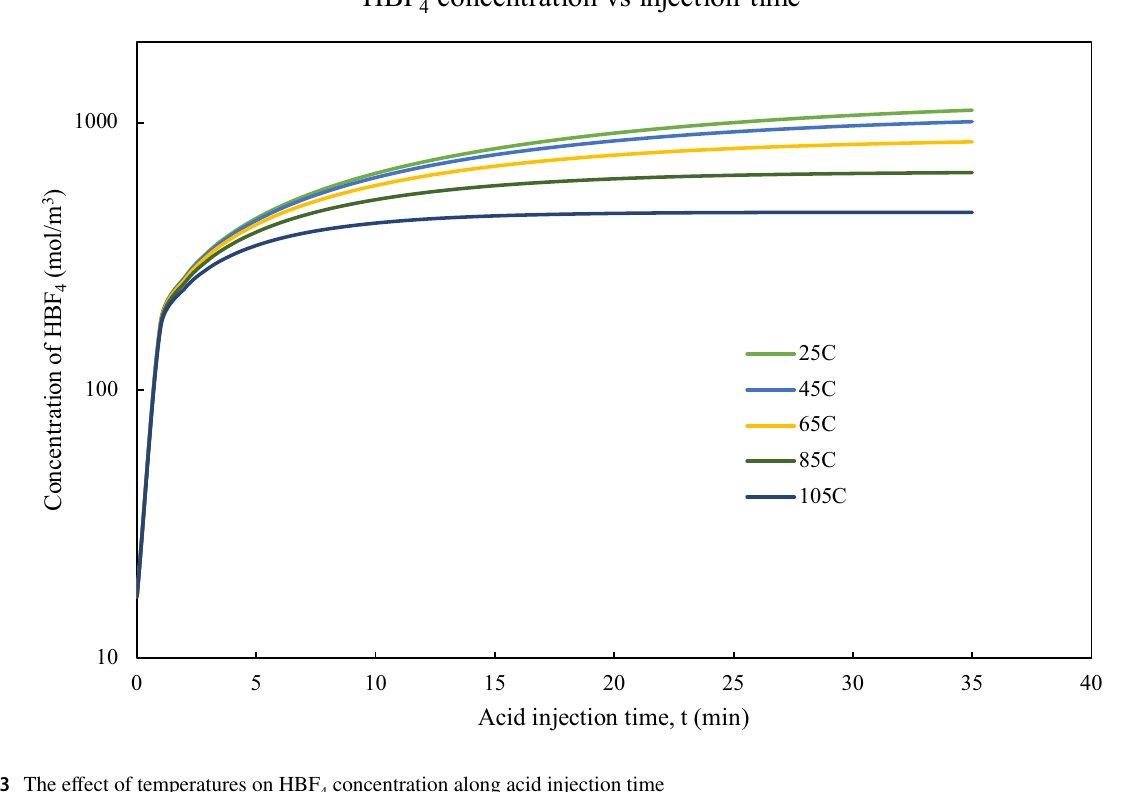
4 concentration along acid injection time